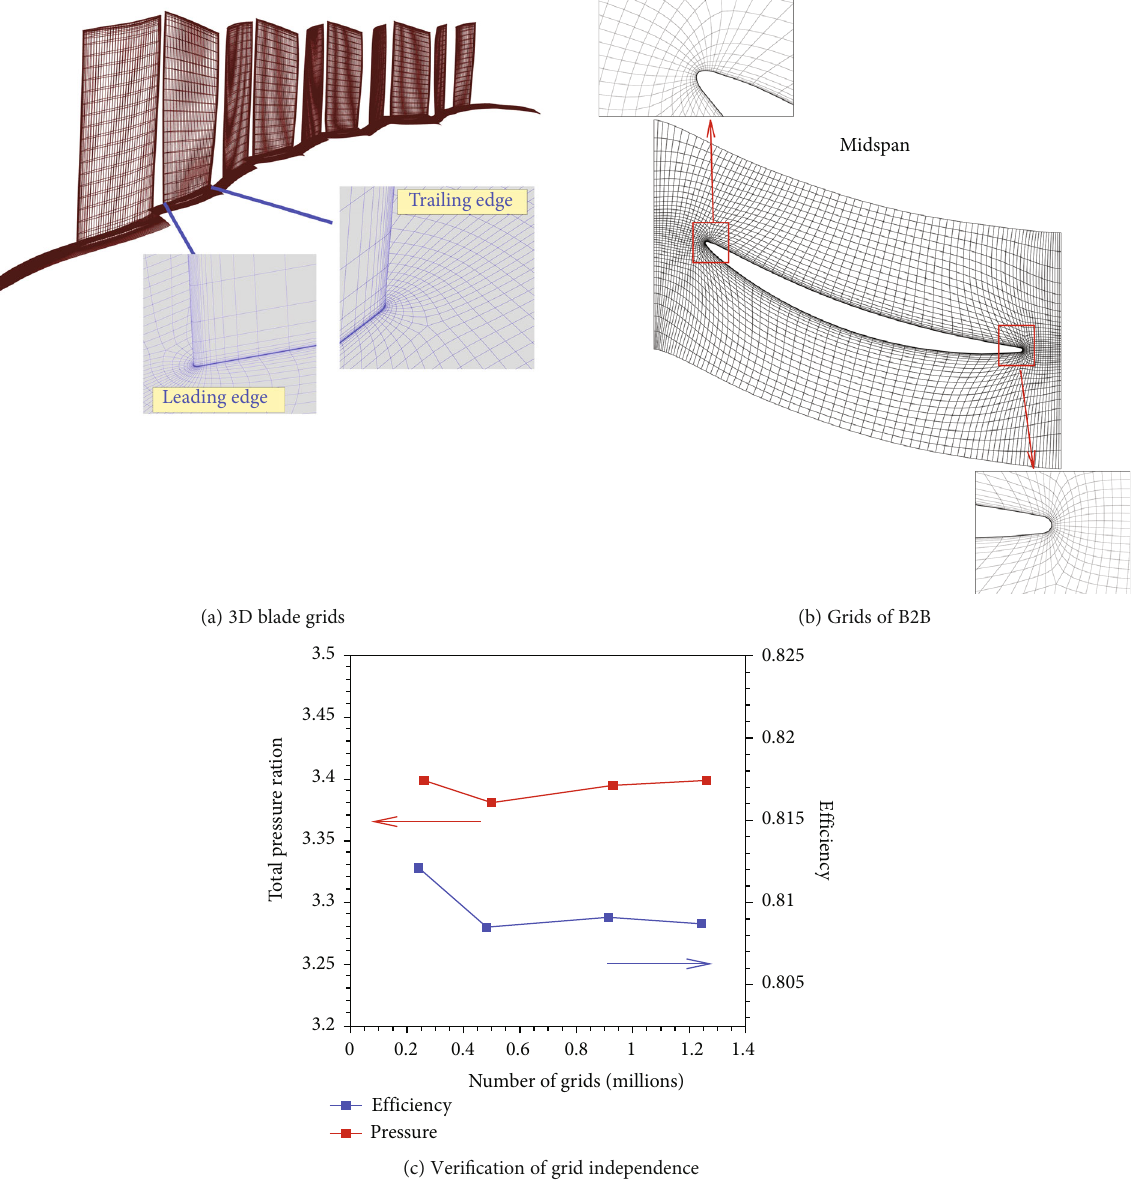
Figure 9: Grid independence veri fi